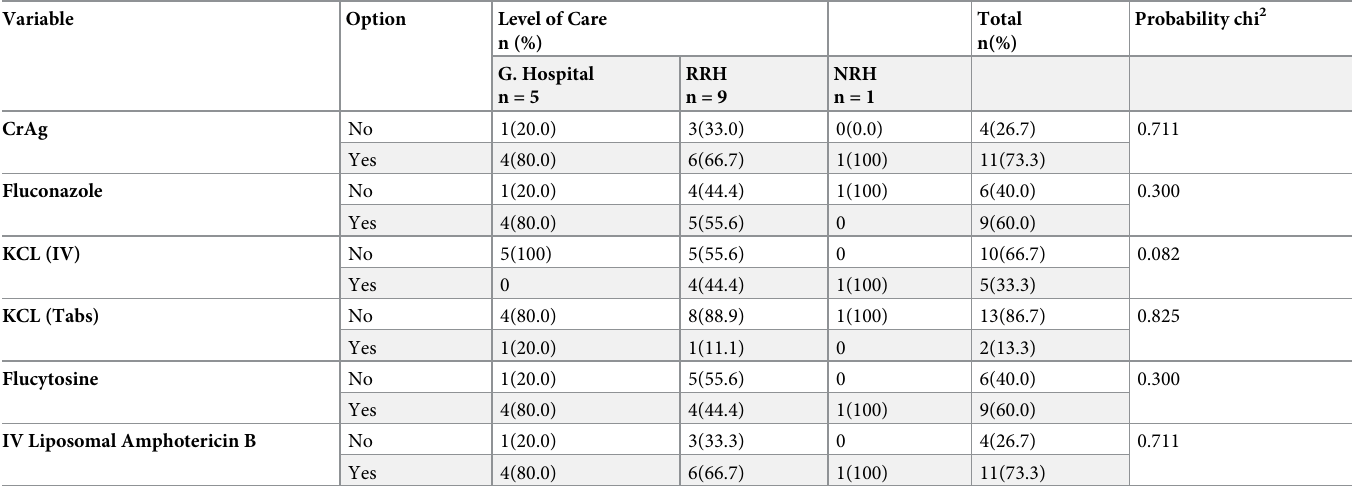
Table 4. Management of CM supplies at the selected